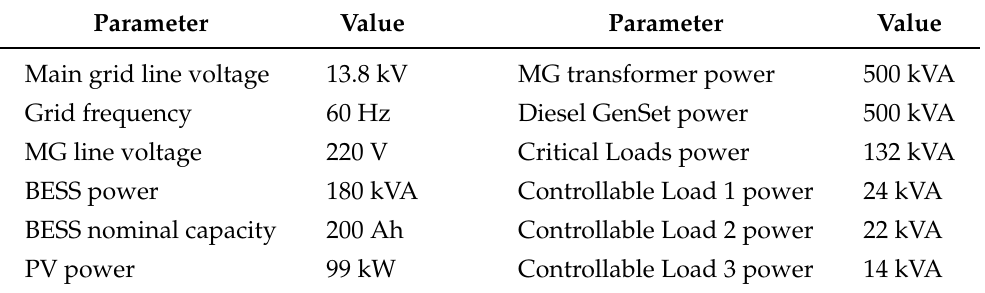
Table 1. COGE MG